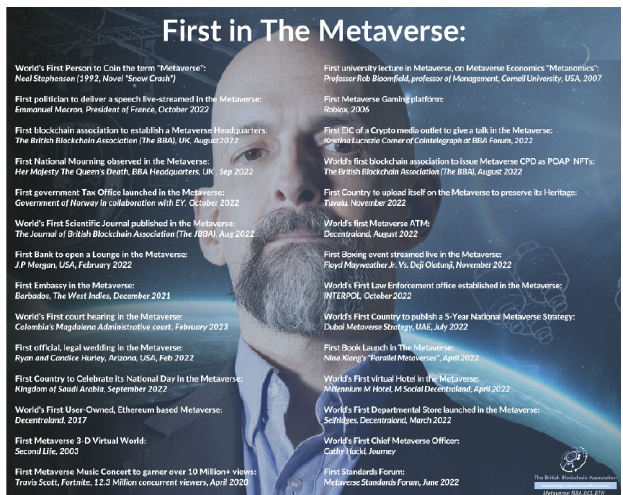
Figure 28: World’s First Metaverse Initiatives Sports in the